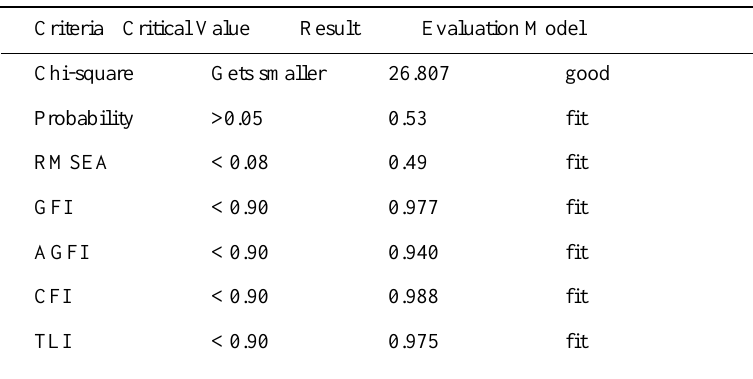
Table 4: Goodness of